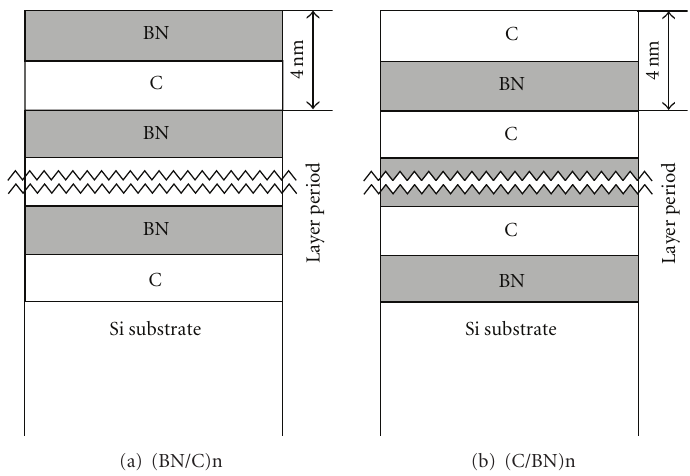
Figure 15: Schematic of layers and thickness of 4-nm-period multilayer (a) (BN/C)n and (b) (C/BN)n films.